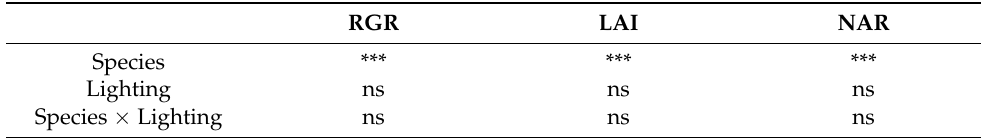
Table 2. Significance levels of the average relative growth rate (RGR), leaf area index (LAI), and net assimilation rate (NAR) for Species, Lighting, and Species × Lighting over a 10 day period.